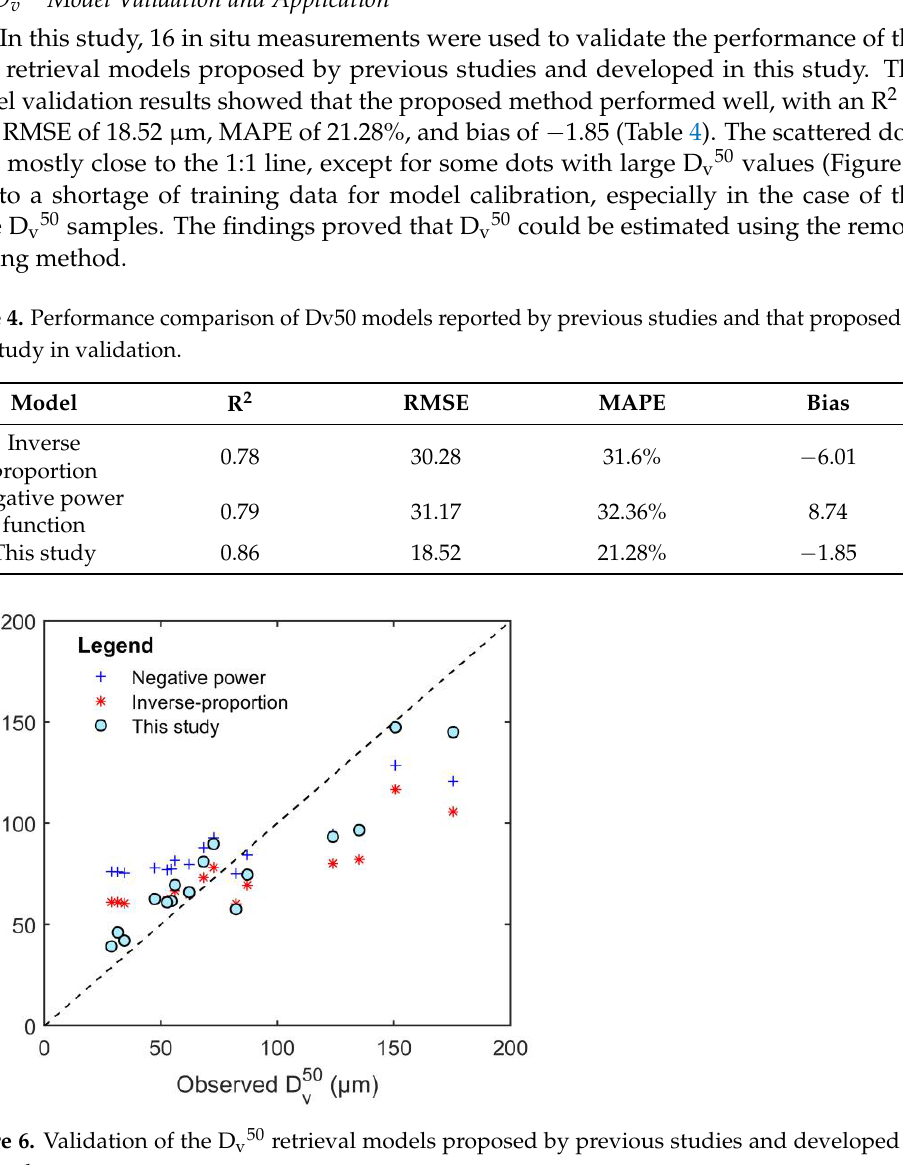
Table 3. Comparison of Dv50 models reported by previous studies and that proposed in this study in calibration.